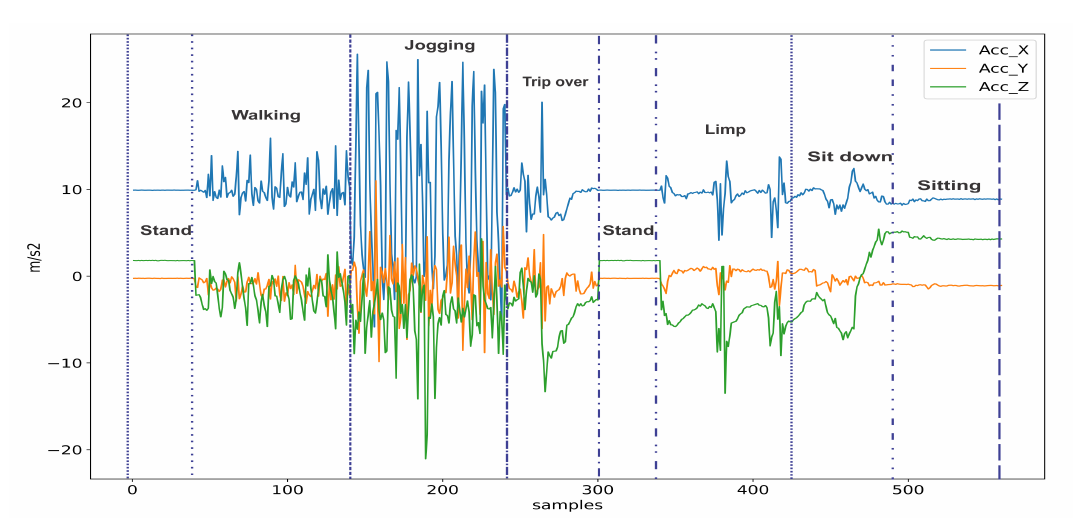
Fig 19. The actual sequencing of activities in an experiment.